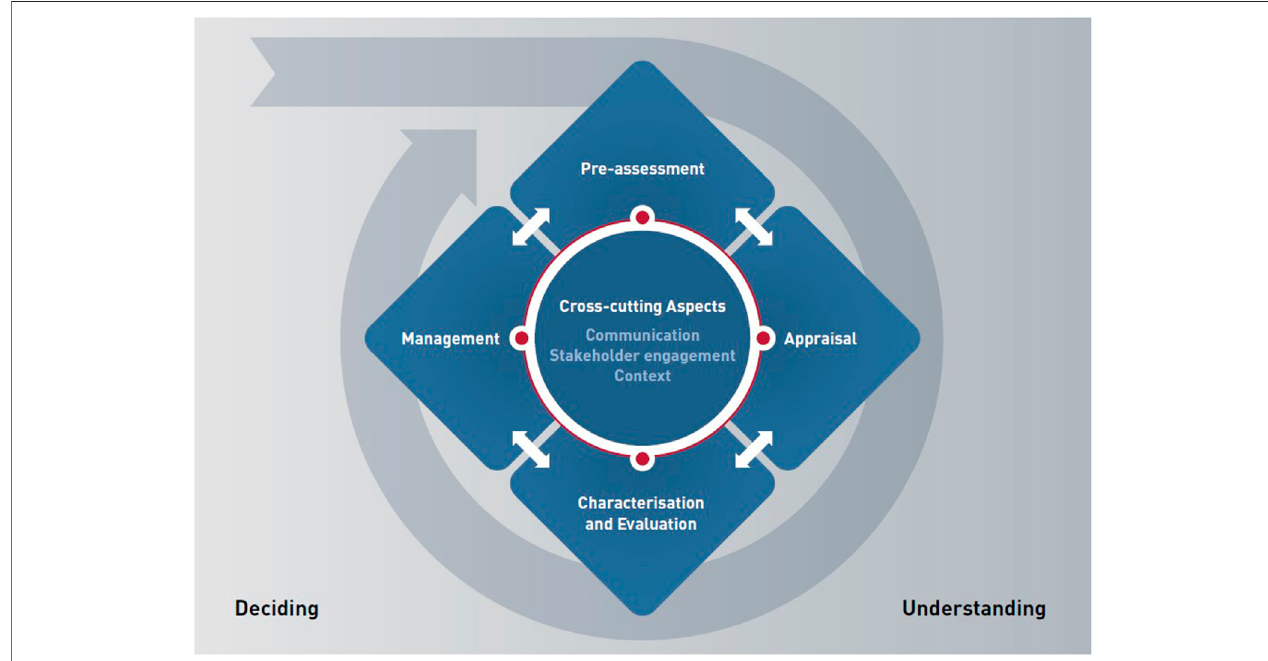
FIGURE 1 | The IRGC risk governance framework IRGC